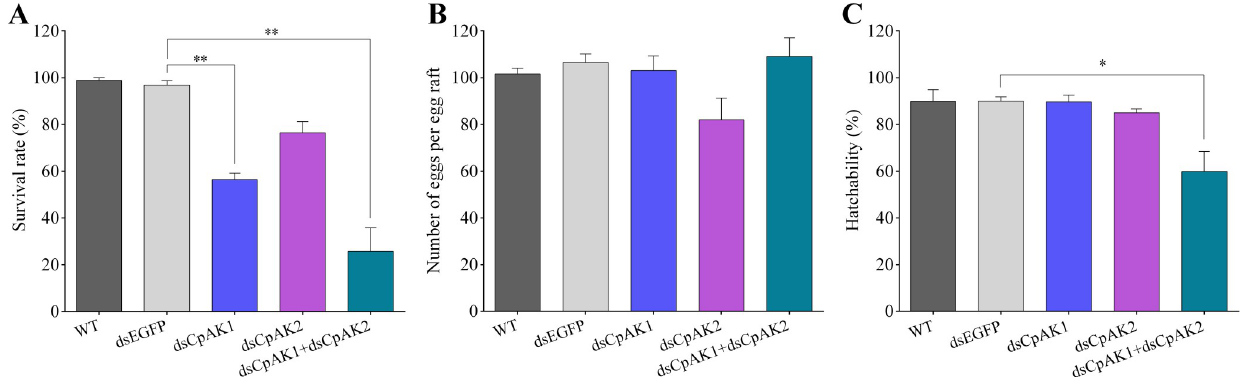
Fig 6. Survival rates (A) of different treatments at 48h after injection. Number of eggs per egg raft (B) and hatchability (C) of female mosquitoes in different treatment groups. All data were expressed as the mean ± Standard Error (SE). Significant difference was analyzed by one-way ANOVA test ( � P < 0.05, �� P <